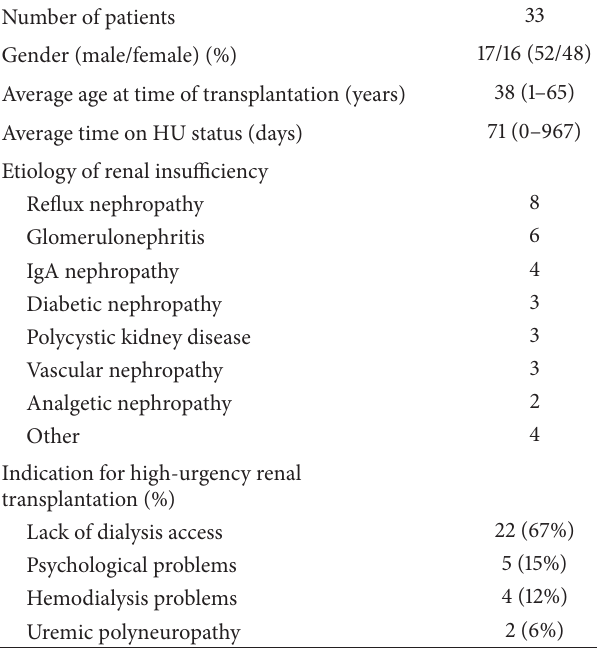
Table 1: Recipient demographics, etiology of the renal disease, and indication for HU renal